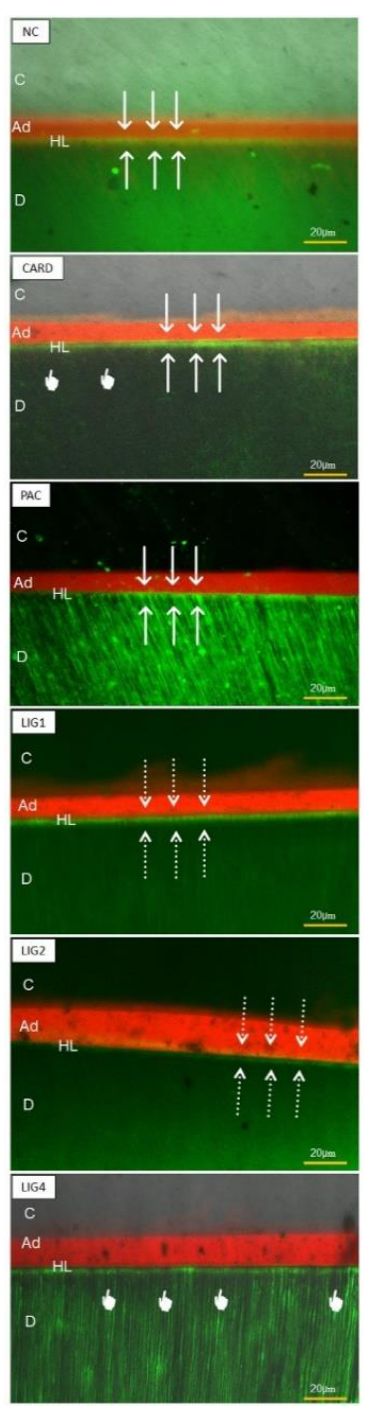
Figure 3. Confocal microscopy images representing the most common micropermeability outcomes at the bonding interfaces of resin-dentin specimens tested in this study. The pointers represent the protected hybrid layer; the arrows represent large infiltration of fluorescein; dotted arrows represent little infiltration of hybrid layer. In general, most prominent micropermeability was observed in negative control and PAC-treated specimens, whilst less micropermeability was found in those specimens treated with 4% lignin. NC: Negative Control; CARD: Cardanol; PAC: Proanthocyanidin; LIG: Lignin; C: composite layer; Ad: adhesive layer; HL: hybrid layer; D: dentin. The presence of most of the biomodification agents tested in this study decreased the DC (Table 1), except for LIG1, which attained a significantly lower DC than the negative control ( p < 0.05). No statistical difference ( p = 0.695) was found between NC and LIG1.